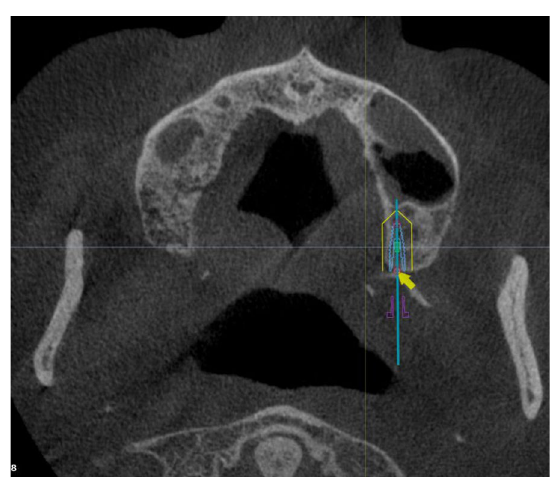
Fig. 3 Create a 10 mm implant from the marked point forward and adjust the position of the implant so that it is parallel to the